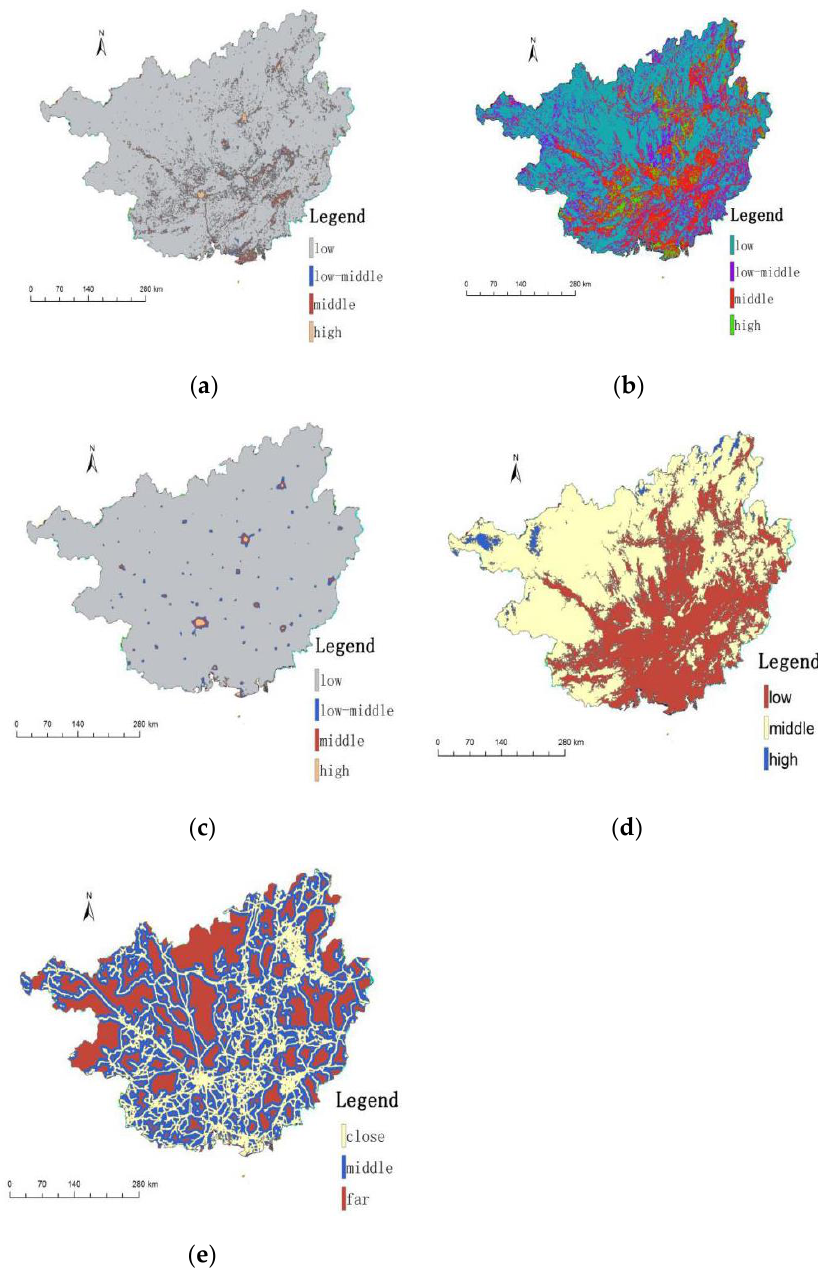
Figure 4. Guangxi GDP ( a ); population density ( b ); lighting data ( c ); DEM ( d ); road distance ( e ) spatial distribution map.